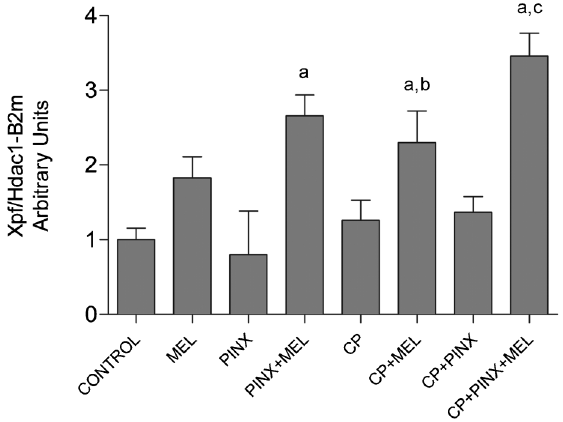
Figure 3. Xpf mRNA expression in bone marrow cells. The values were normalized by Hdac1 and B2m mRNA expression and are reported as arbitrary units. MEL = melatonin; PINX = pinealectomized animals; CP = cyclophosphamide. Data are reported as means ± SE for n = 5 animals per group. a P , 0.05 vs control and PINX; b P , 0.05 vs CP; c P , 0.05 vs CP and CP + PINX (one-way ANOVA followed by the Bonferroni multiple comparisons post hoc